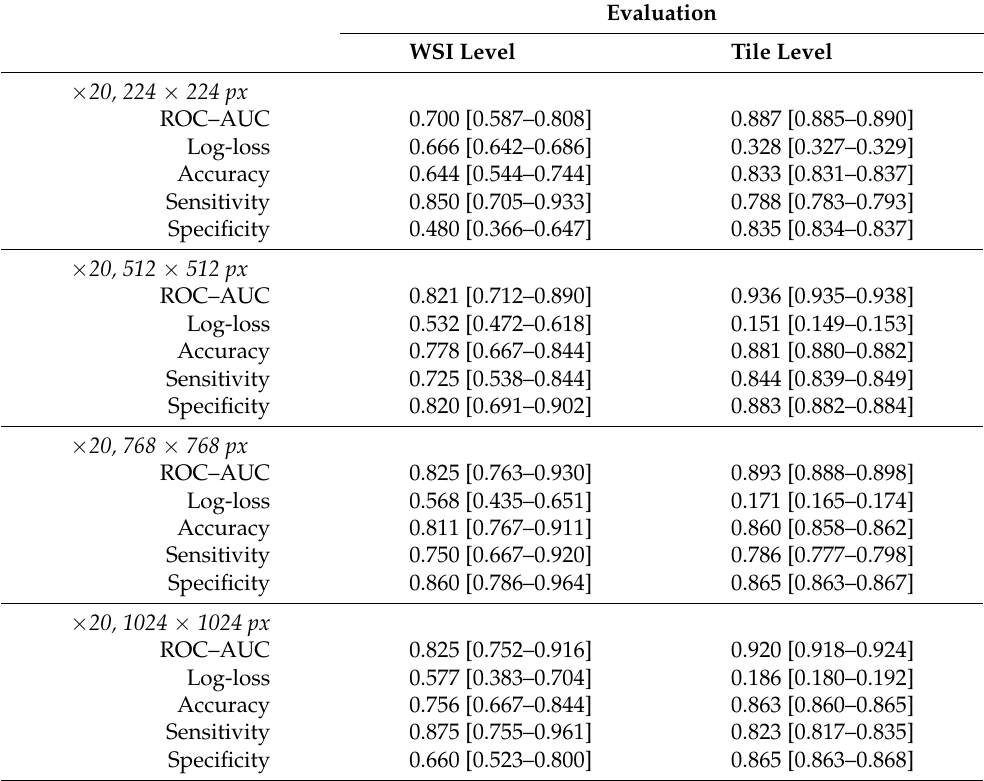
Table 4. Results of the test set of whole-slide image (WSI) level and tile level using multiple metrics.